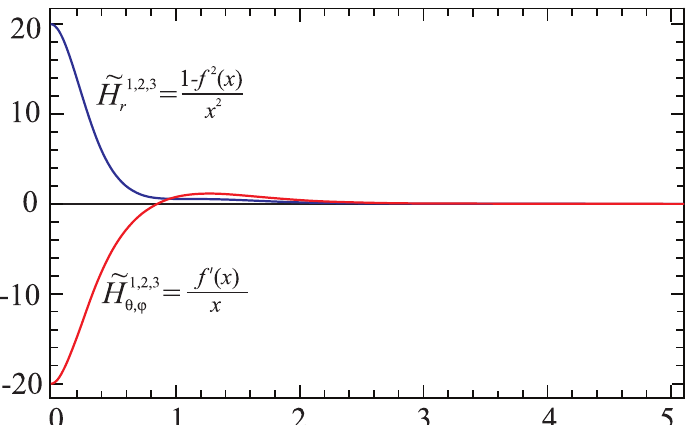
Figure 2. The profiles of the magnetic fields ˜ H 1,2,3 r and ˜ H 1,2,3 monopole